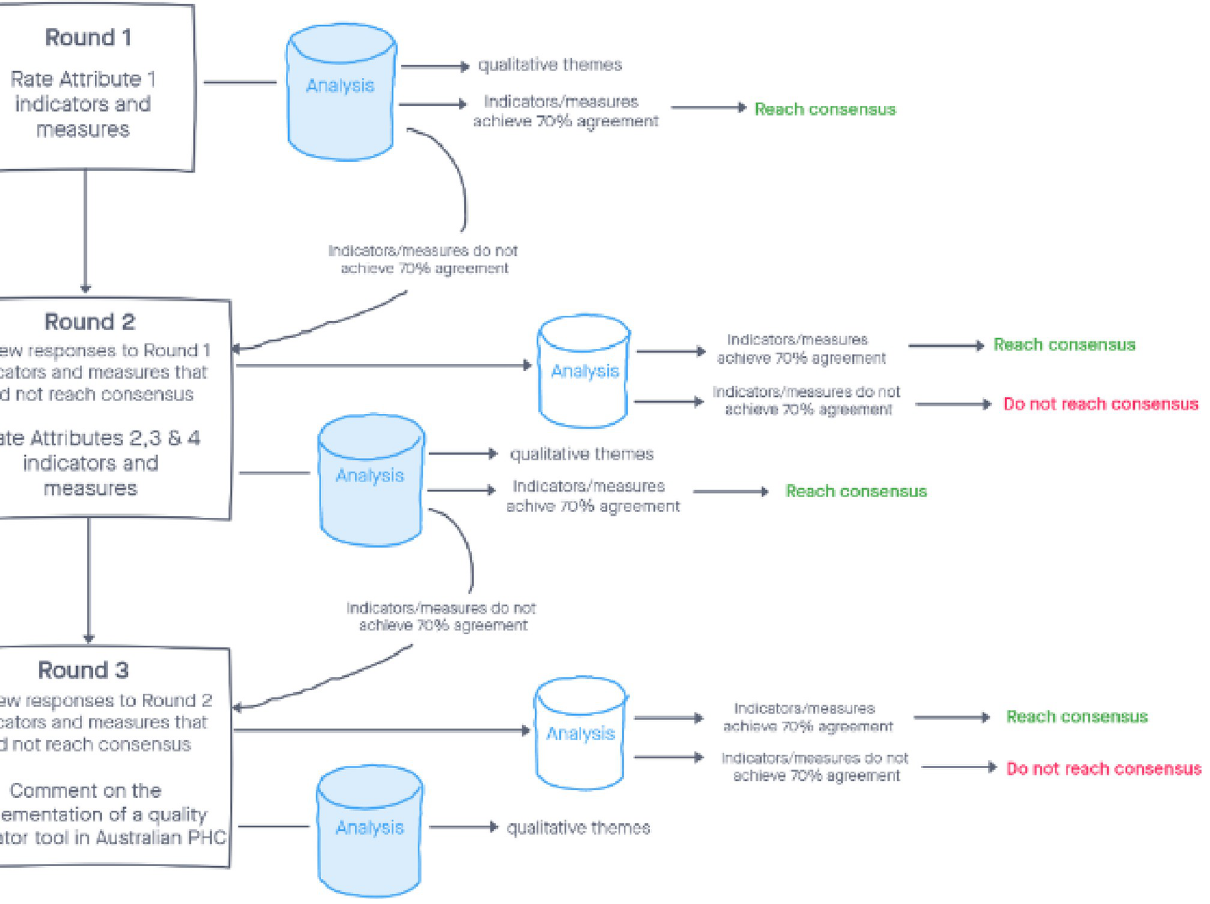
Fig 1. Delphi survey rating